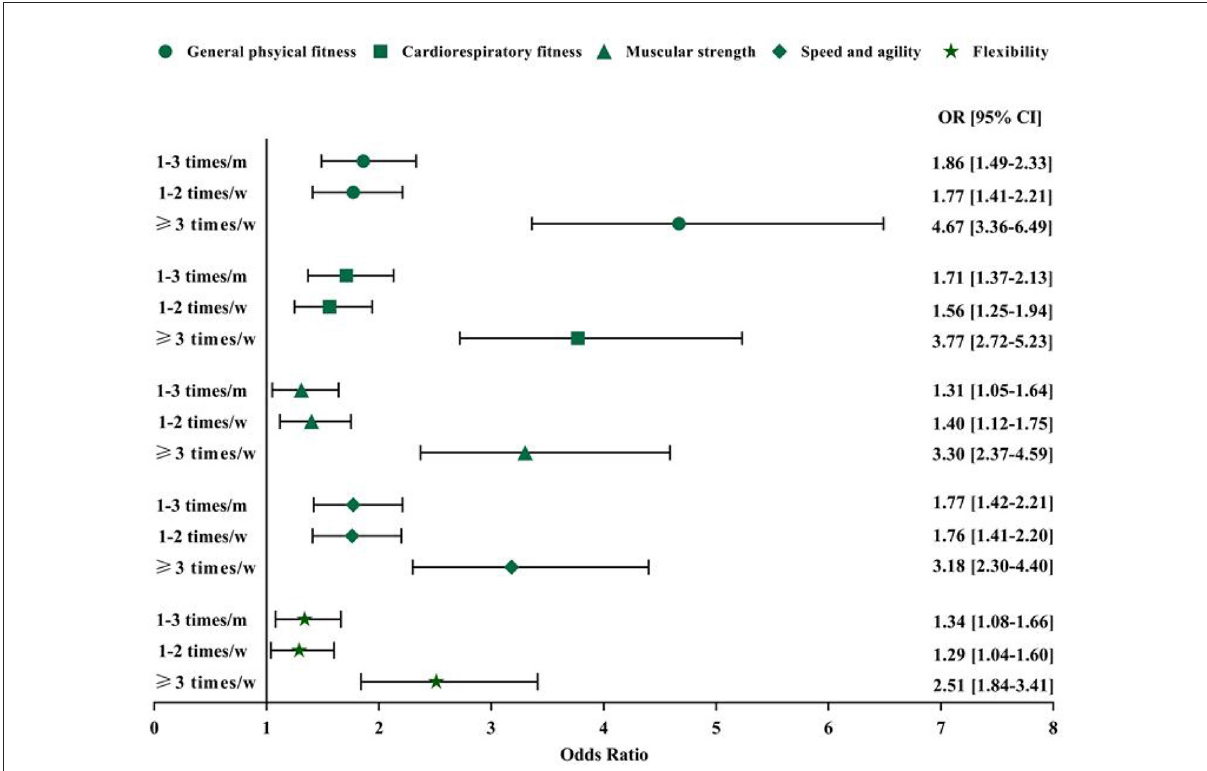
FIGURE2 Association between frequency of sports participation and self-reported health-related physical fitness indicators. Model controlled for age, sex, siblings, living with parents or not, grade, residence, father and mother education level, and perceived family affluence, moderate to vigorous physical activity, recreational screen time and sleep duration. m, month; w, week; OR, odd ratio; CI, confidence interval. Reference group: